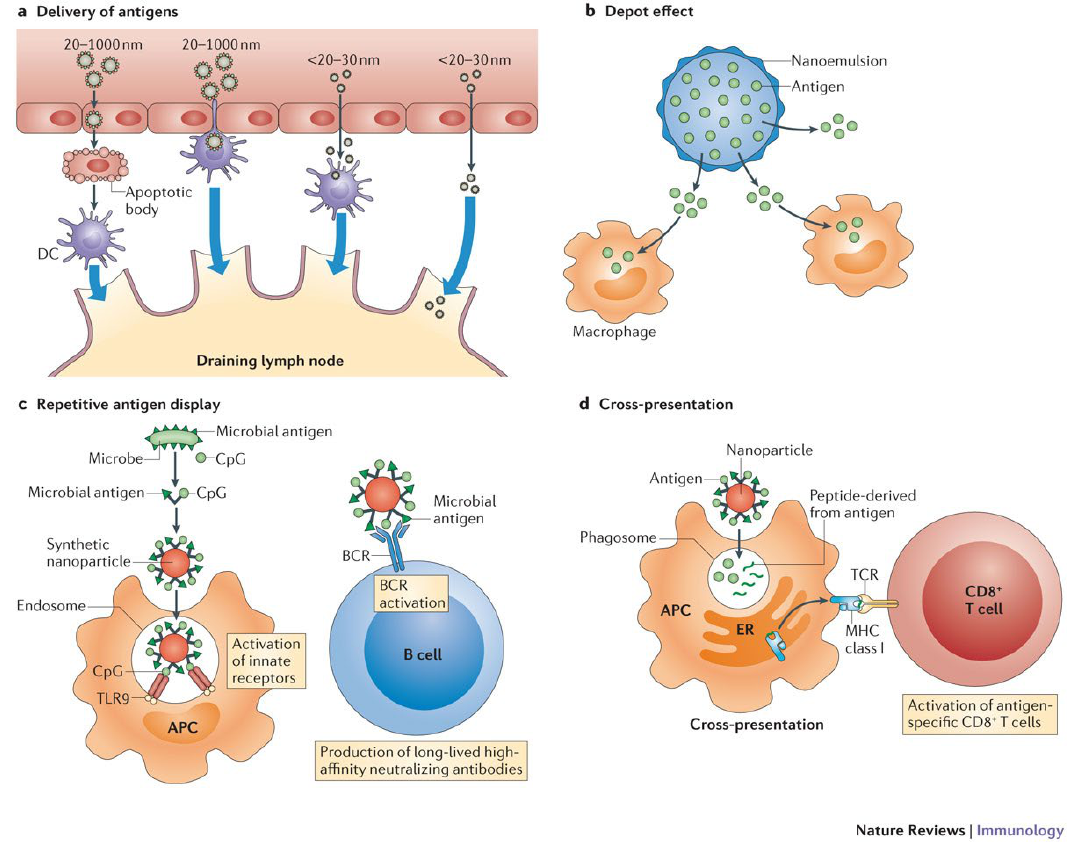
Figure 2. Immune response induction and how nanoparticles affect it [30]. Reproduced with per- mission from [30]. Copyright Springer, Nature, 2013.